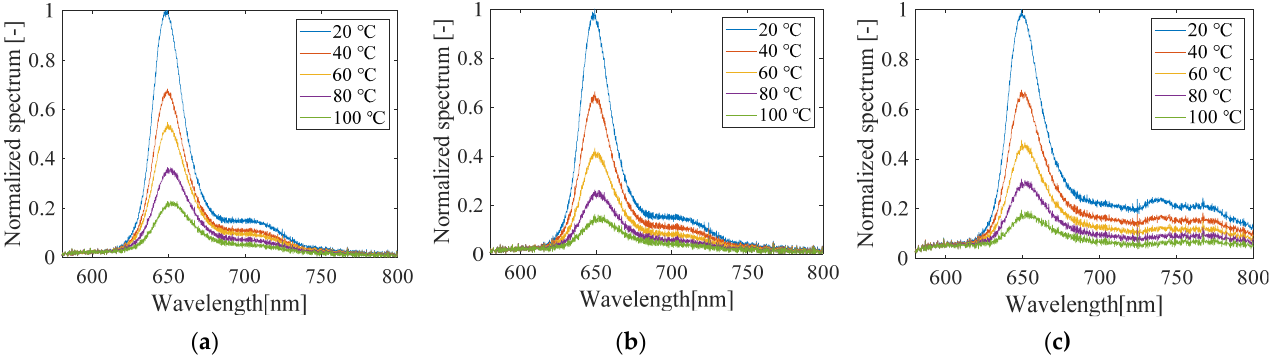
Figure 10. Luminescence spectra of PC-PSP ( a ) before and ( b ) after the heat treatment and ( c ) after photodegradation.